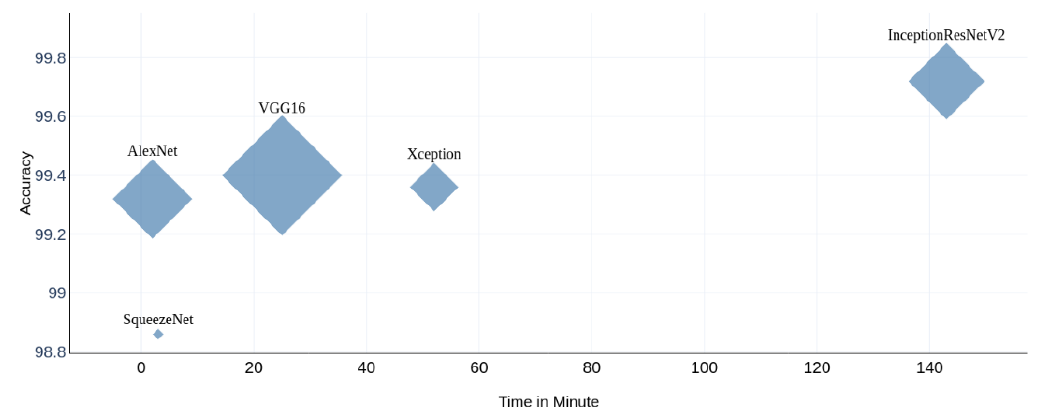
Figure 15. Classification accuracy versus training time for the five deep transfer learning models. InceptionResNetV2 achieved the highest accuracy but consumed the longest time. SqueezeNet and AlexNet were faster and achieved comparable accuracies.